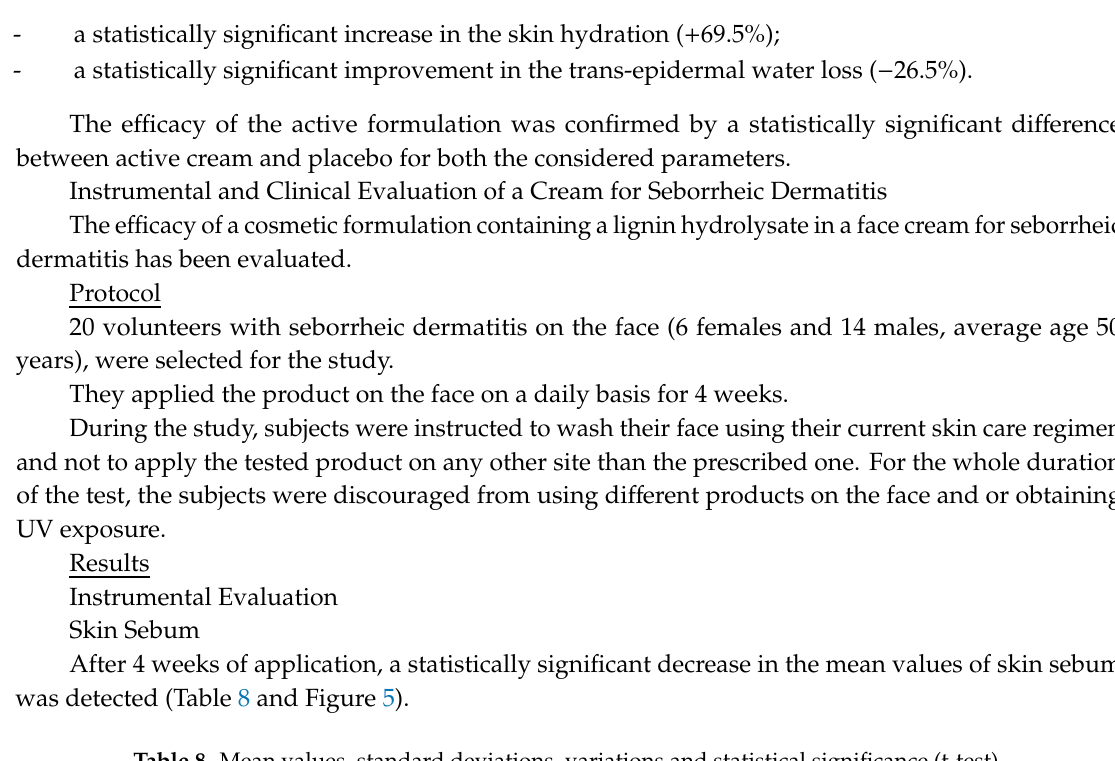
Table 8. Mean values, standard deviations, variations and statistical significance